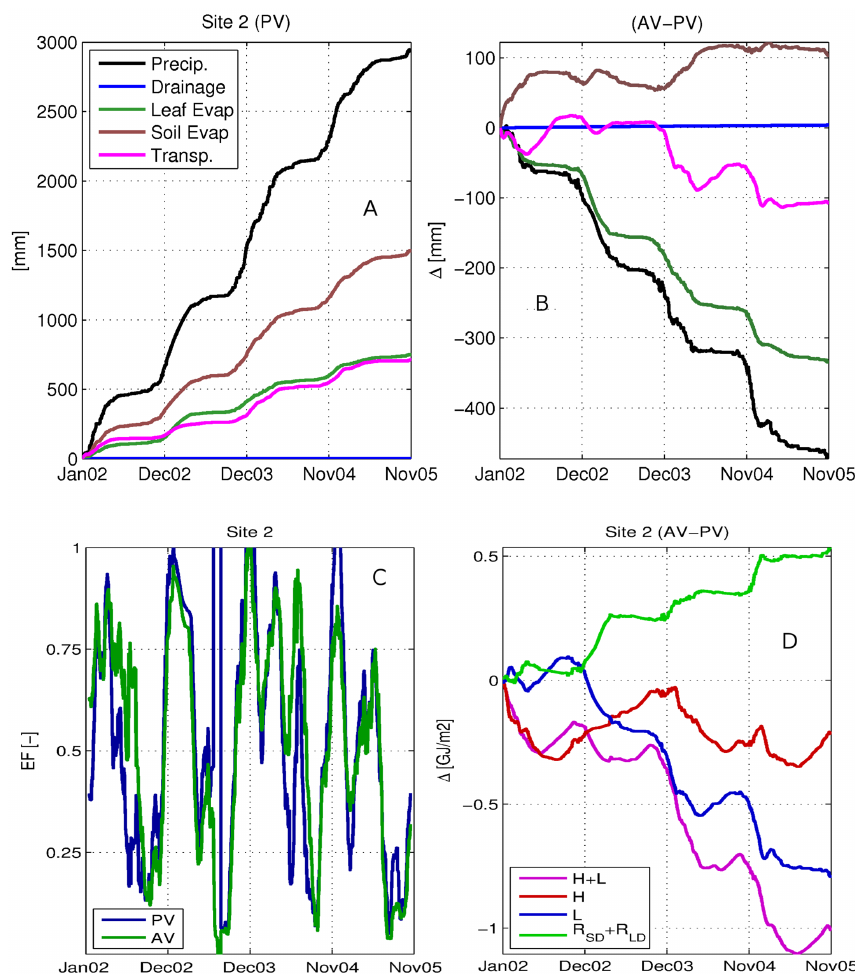
Figure 9. Time series analysis of the surface water and energy balance at the Gran Chaco site, 2002–2005. (a) Accumulated water flux for the potential scenario. (b) Accumulated differential water flux between actual (AV) and potential (PV) scenarios. (c) Mean evaporative fraction, latent heat flux ( L ) divided by the sum of latent and sensible ( H ) heat flux ( L /( L + H )). (d) Accumulated differential energy flux in GigaJoules per square meter. R SD is downwelling shortwave radiation incident on the surface, R LD is downwelling longwave radiation incident on the